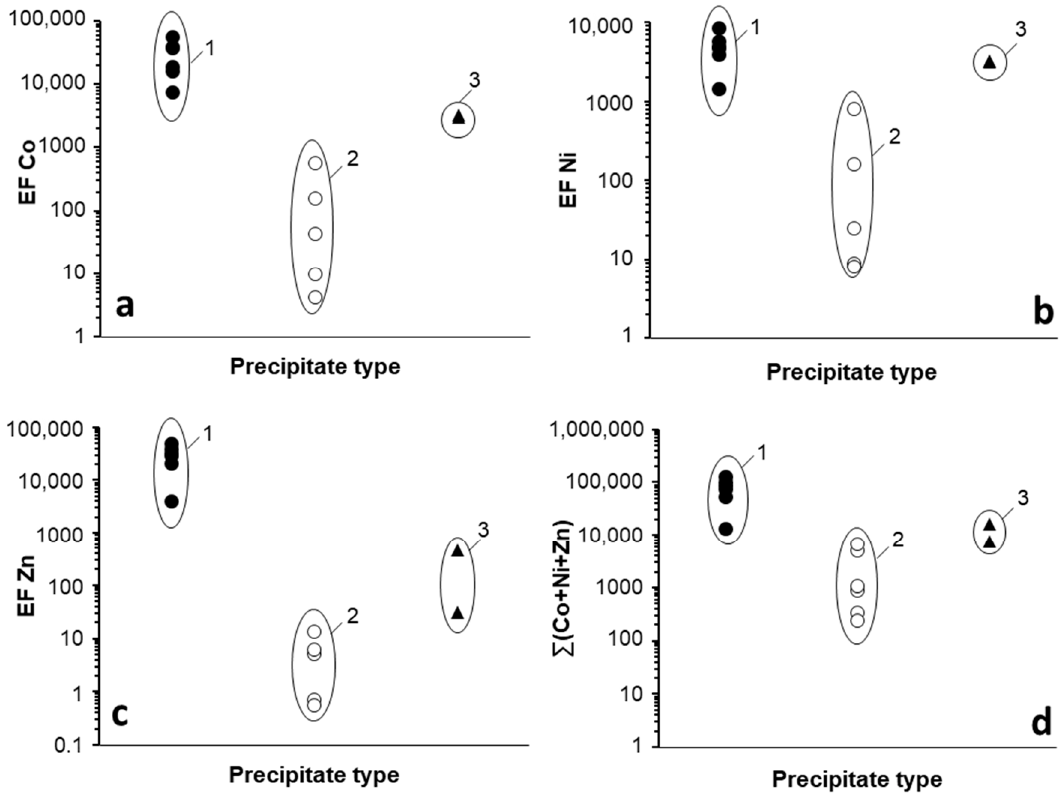
Figure 5. Enrichment factors (EF) of Co ( a ), Ni ( b ), and Zn ( c ), and cumulative trace metal content ( ∑ (Co + Ni + Zn)) ( d ) for Mn oxides formed at different conditions: (1) in situ precipitates formed during slow Mn(II) oxidation in the water column of Reocín pit lake (pH 7.0–8.0) ( black circles ); (2) precipitates obtained in the lab during slow oxidation of dissolved Mn(II) in mine waters from Guadiana, La Zarza and Brunita (pH 8.5–9.0) ( white circles ); and (3) precipitates obtained in the lab during fast oxidation kinetics in neutralization experiments (pH 9.0–10.0) ( black triangles ). The EF values were calculated on the basis of metal (Co, Ni, Zn) concentrations in Mn oxides (Table 3), and the corresponding metal content in parent solutions (Table 1).